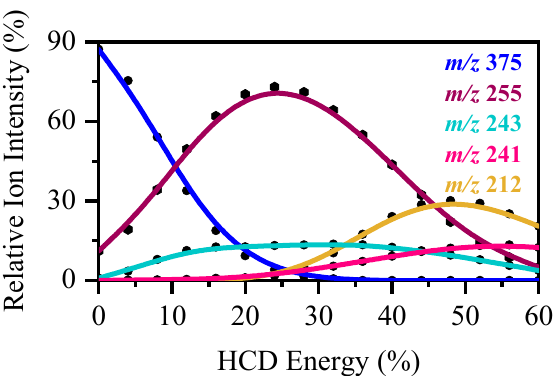
Figure 7. Parent ion dissociation curves [RF − H] − ( m / z 375, electrosprayed in EtOH) and its four most intense thermal fragments between 0% and 60% HCD energy. The curved lines are a five-point adjacent average of such data points and are provided as a viewing guide, to emphasise each fragment’s profile. Section S3 presents complete HCD data for the minor fragments.